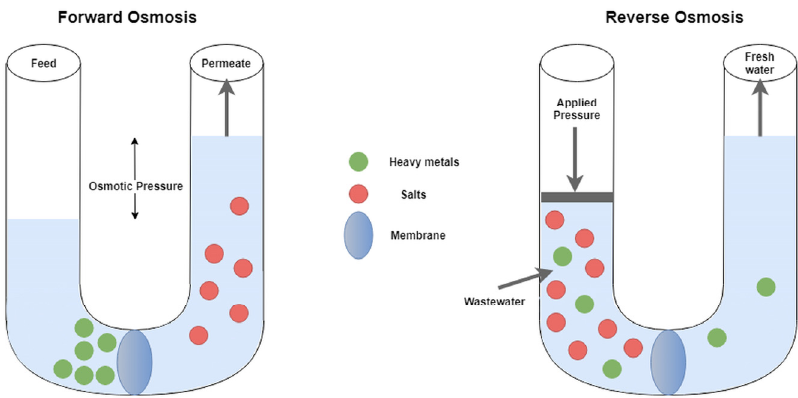
Figure 5. FO vs. RO, exemplified for different classes of pollutants.